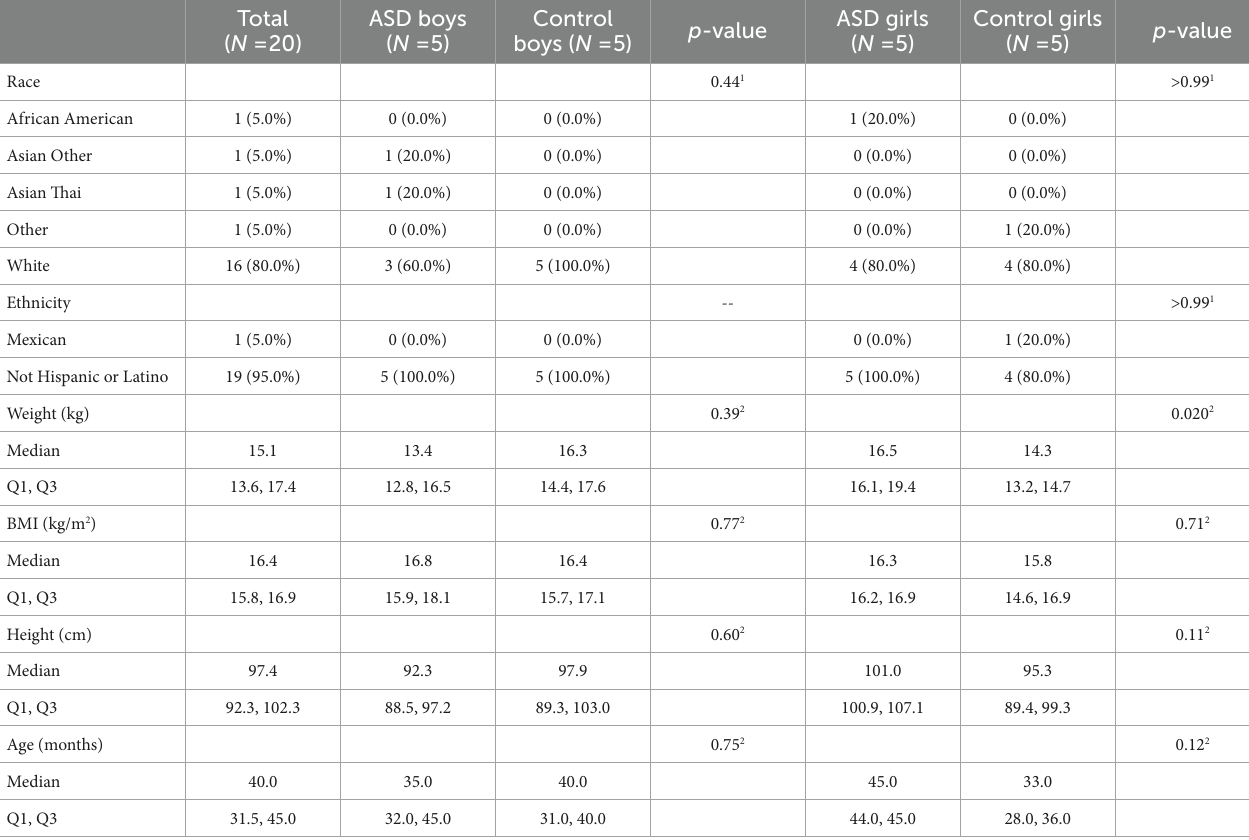
TABLE 1 Characteristics of case and control